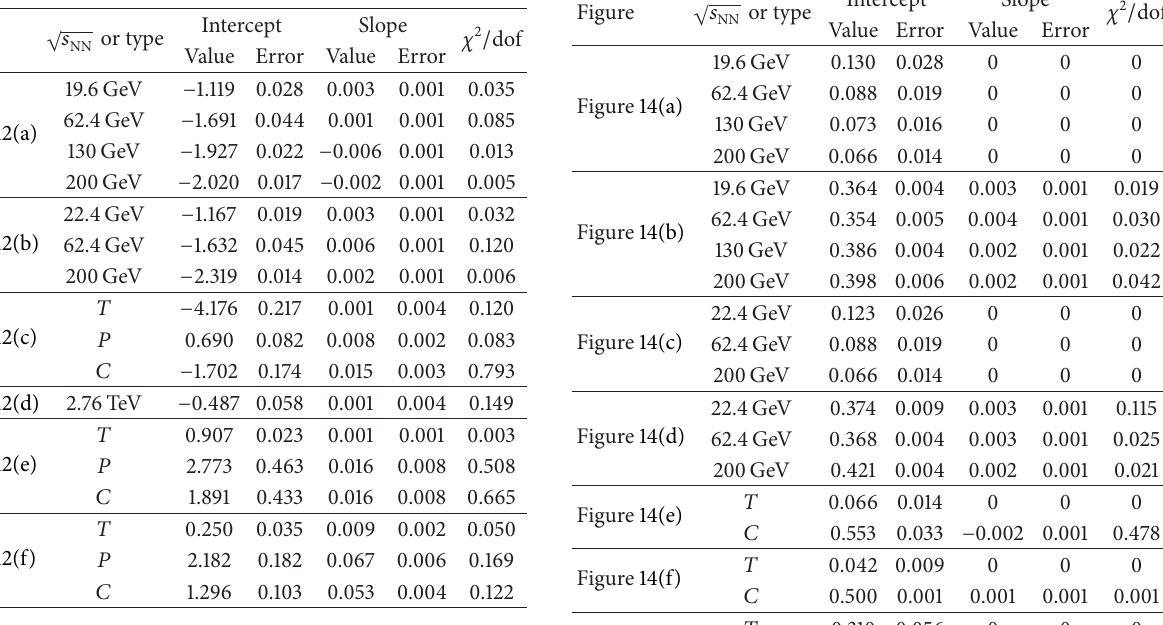
Table 7: Values of intercept, slope, and 𝜒 2 / dof for the linear relations 𝑦 𝑇 - 𝐶 in Figures 12(a), 12(b), and 12(d), for the linear relations 𝑦 𝑇,𝑃,𝐶 - 𝐶 in Figures 12(c) and 12(e), and for the linear in Figure 12(f). relations 𝑦 𝑇,𝑃,𝐶 - √𝑠 NN